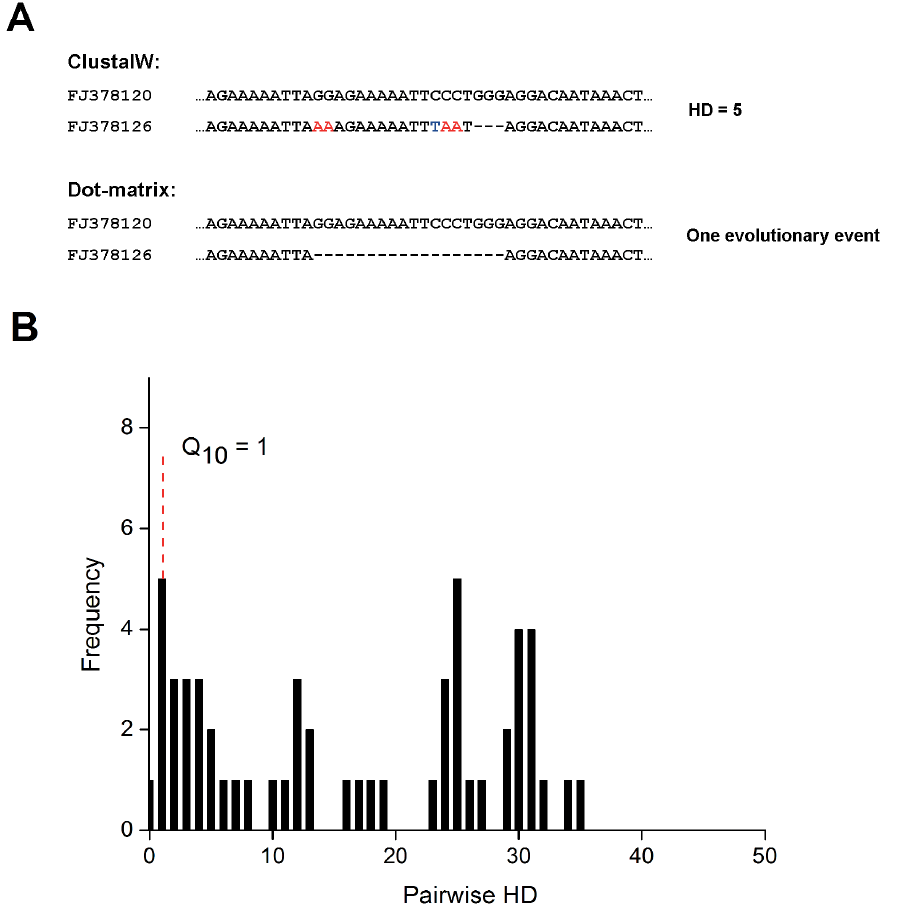
Figure 3. Partial alignment of two sequences from sample ID 1811 (A), along with the sample’s pairwise HD distribution (B). (A) Partial alignment of two sequences from sample ID 1811. Red and blue letters highlight differences in nucleotides. (B) The pairwise HD distribution of sequences from sample ID 1811, which was misclassified as a chronic case by the HD Q 10 assay (HD Q 10 =1). The sample comprised of 11 sequences and was obtained at Fiebig stage